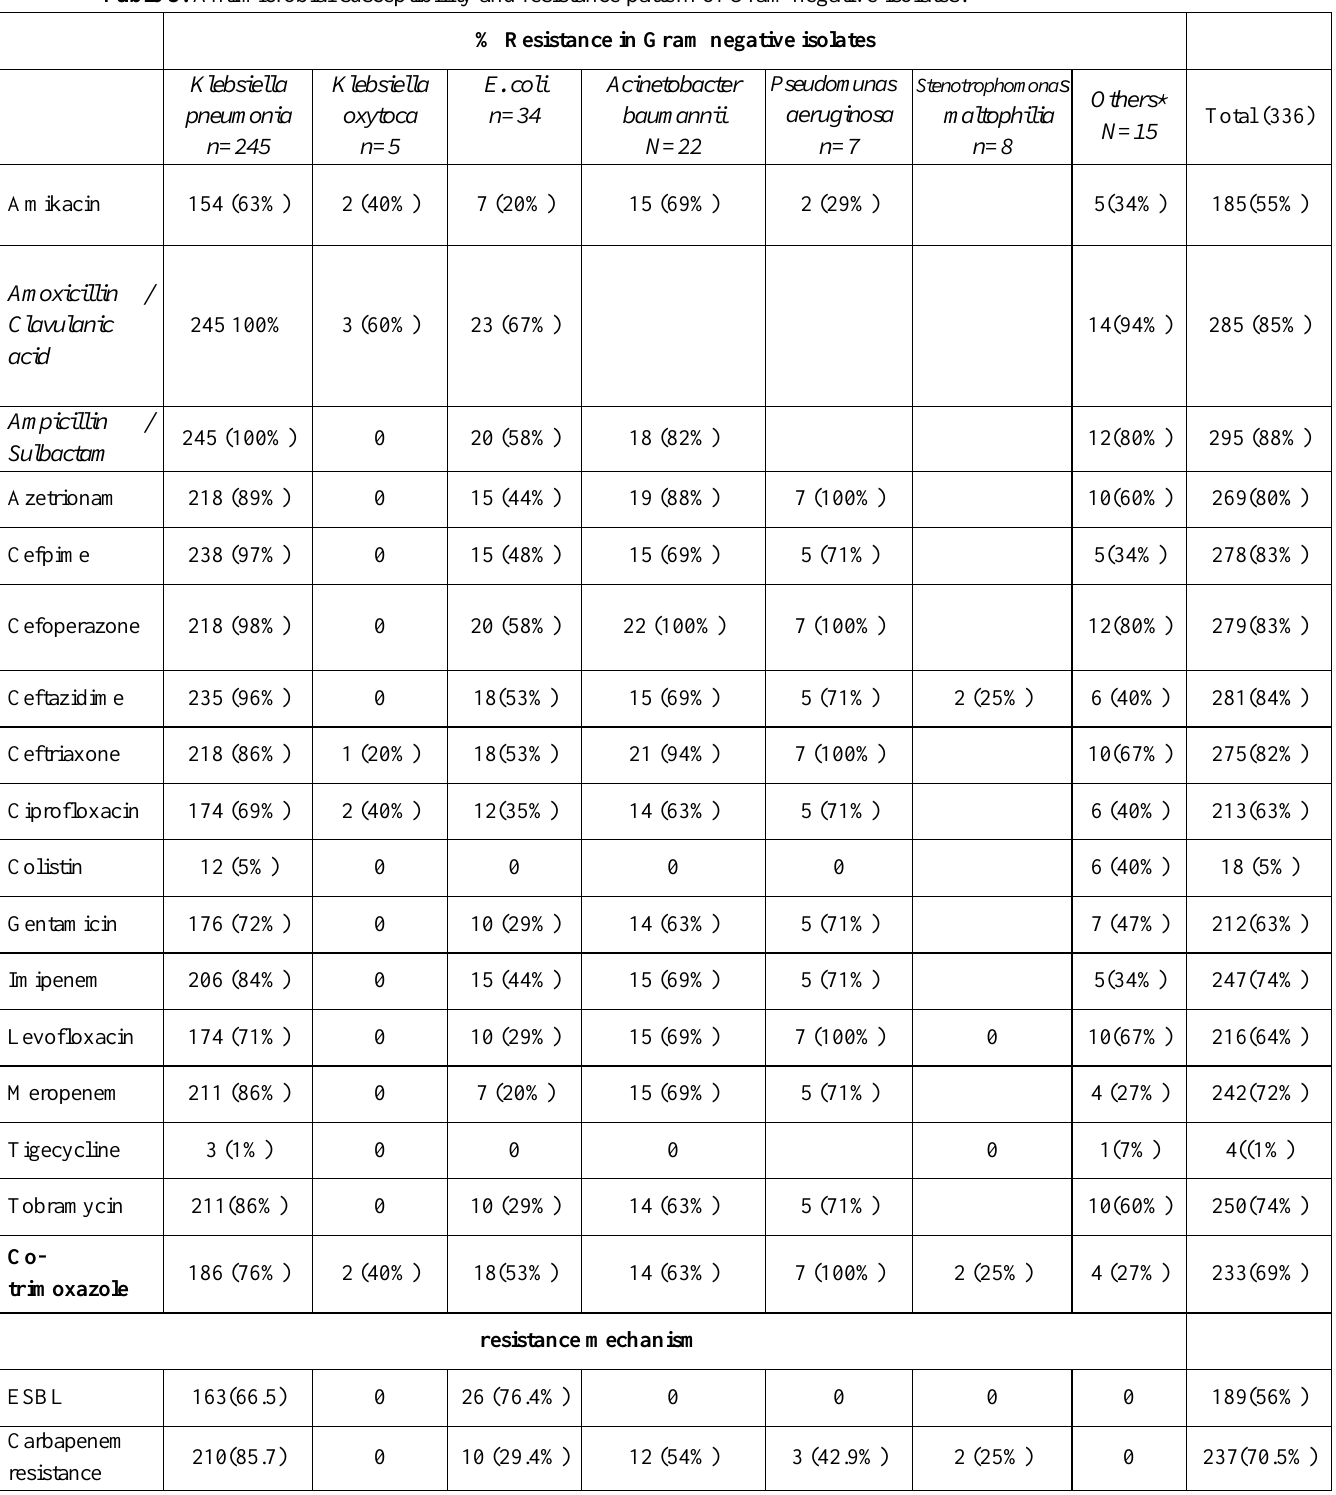
Table 3. Antimicrobial susceptibility and resistance pattern of Gram negative